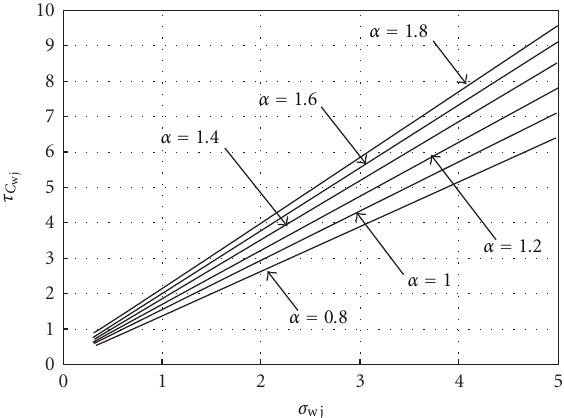
Figure 12: Cavitation coe ffi